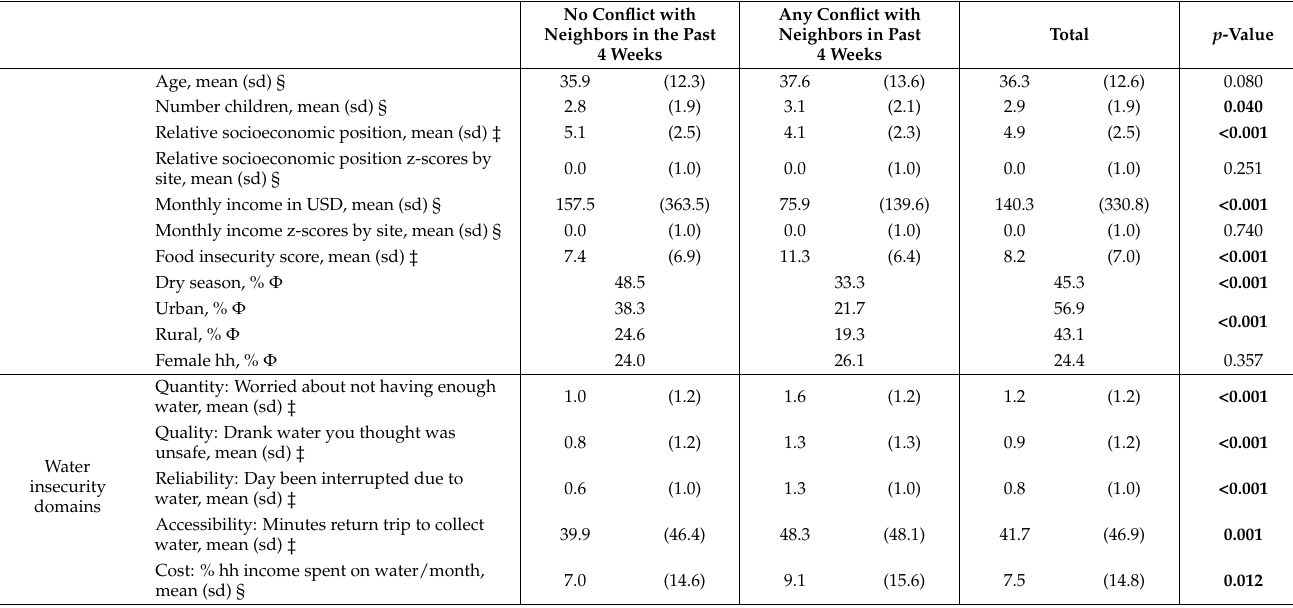
Table 2. Descriptive statistics for demographics and water insecurity domains by whether or not the household experienced conflict with neighbors in the past four weeks. p -values are for group difference